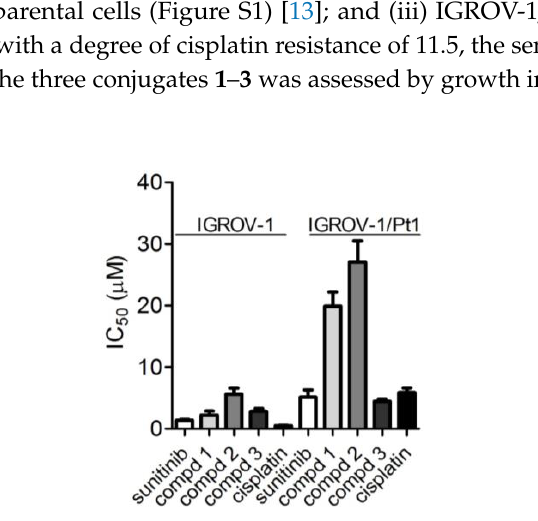
Figure 3. Sensitivity to sunitinib, conjugates 1 – 3 and cisplatin as assessed by cell growth inhibition assays. Cells were seeded and 24 h later exposed to the compounds for 72 h. Cells were then counted using a cell counter. IC 50 is defined as the concentration inhibiting cell growth by 50%. The IC 50 values of the c(AmpRGD) per se were 6.04 ± 2.8 μ M in IGROV-1 cells and >30 μ M in IGROV-1/Pt1 cells. Sensitivity relative to sunitinib is: 1.59, 4.00, 2.01 for compounds 1 , 2 , and 3 , respectively, in IGROV-1 cells, and 3.88, 5.28, 0.86 for compounds 1 , 2 , and 3 , respectively, in IGROV-1/Pt1 cells.